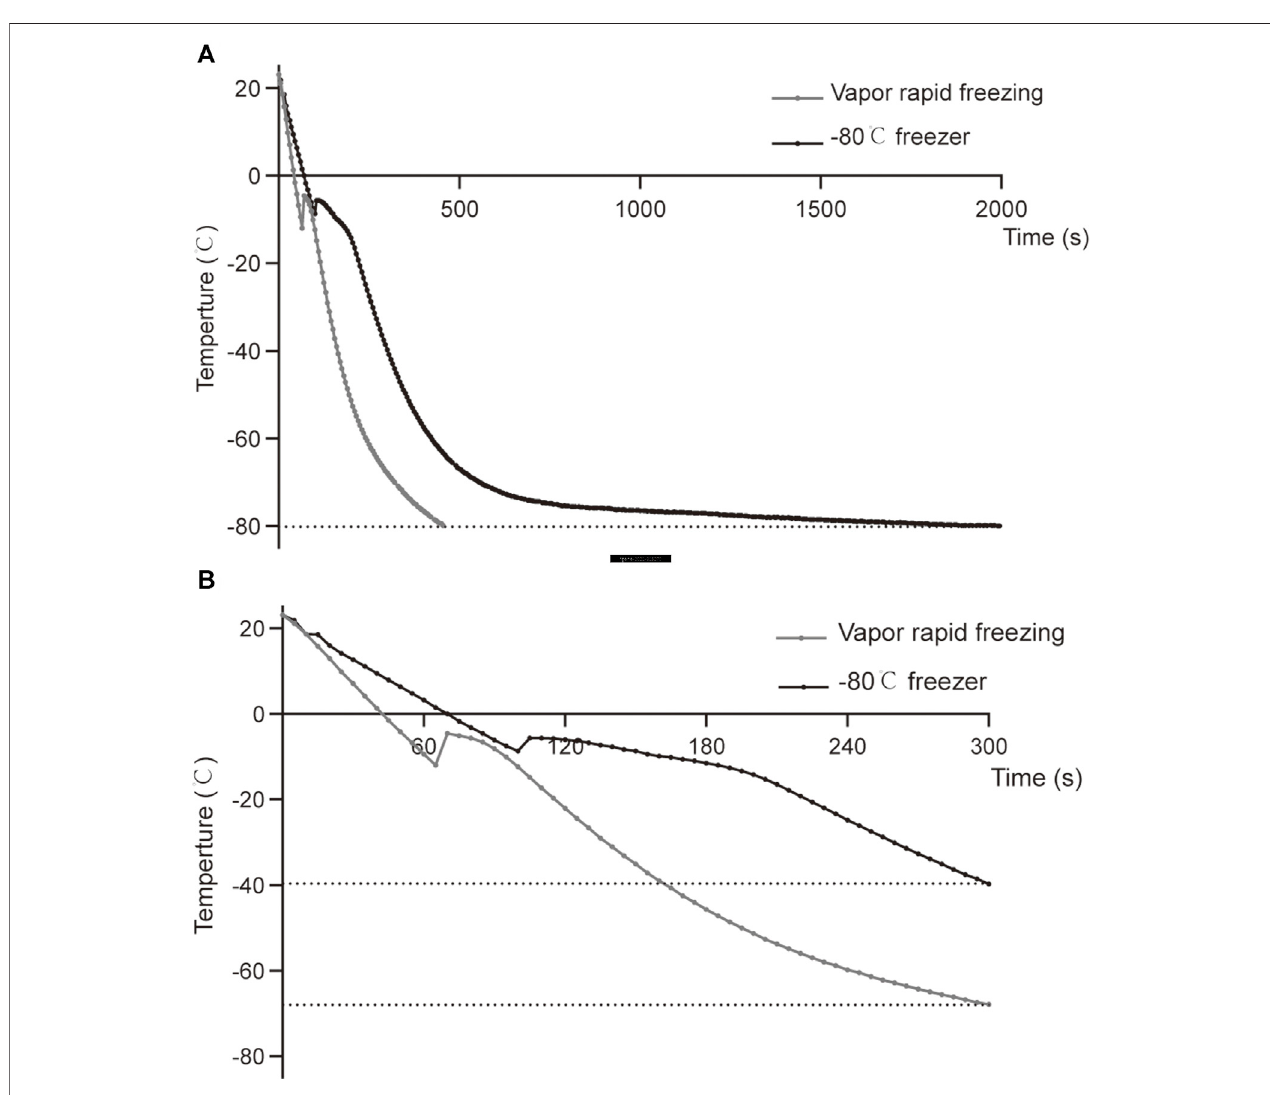
FIGURE 2 | Comparison of temperature curves of vapor rapid freezing and − 80 ° C freezer. (A) The temperature drop curve of sperm samples from RT to − 80 ° C in liquid nitrogen vapor rapid freezing and − 80 ° C freezer. (B) The temperature drop curve of the sperm samples in the fi rst 300 s of liquid nitrogen vapor rapid freezing and − 80 ° C